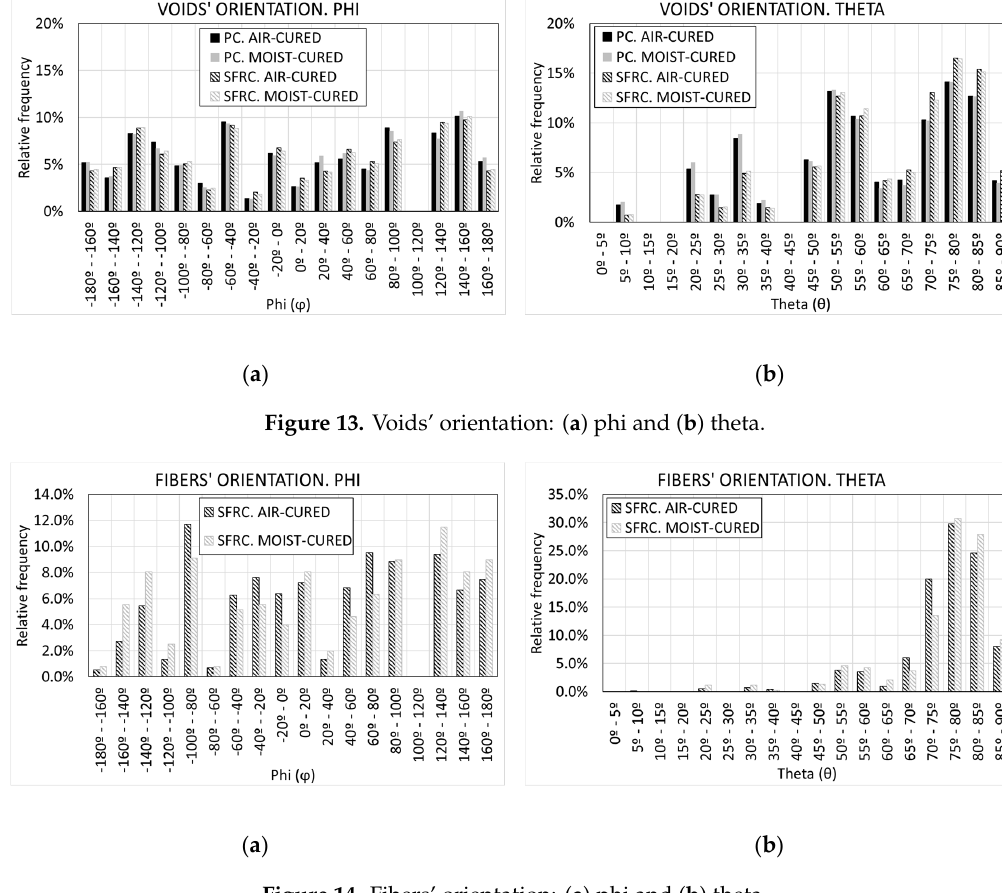
Figure 14. Fibers’ orientation: ( a ) phi and ( b ) theta.